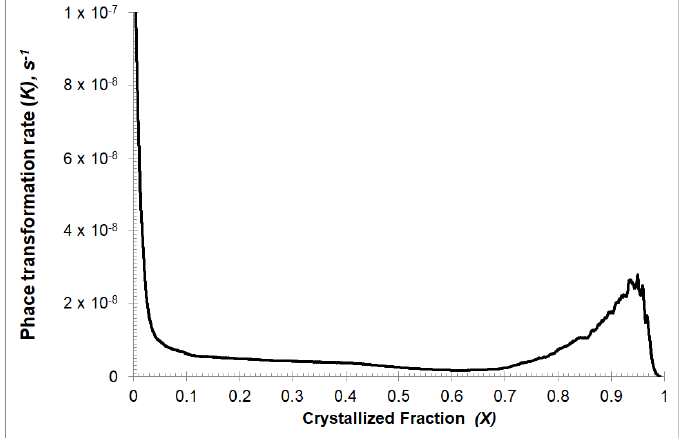
Figure 5. The phase transformation rate K ( X ) varied with crystallized fraction X for isothermal annealing temperature equal to 507 K.